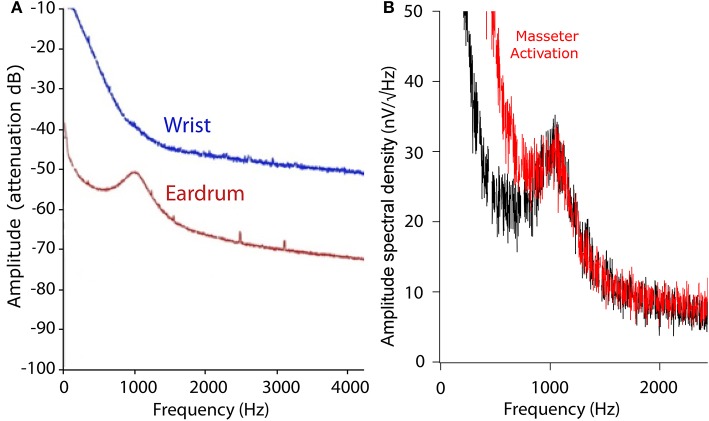
Tympanic electric noise ECG-like and EMG controls. (A) Comparison between TEN and ECG-like spectrums. The blue line shows the averaged spectrogram of a 360 s recording from an ECG-like signal with wrist electrodes, while the red line shows the spectrum of the TEN signal in the same volunteer. To compare the wrist and eardrum noise signal, the y-axis is shown in arbitrary units measured in dB of attenuation. The frequency components of the ECG-like signal are probably observed in the low frequency band (<100 Hz) of the corresponding power spectrum. (B) TEN spectrum with (red) and without (black) masseter muscle activation. Volunteers activated their masseter muscles through isometric contraction, with mouth closed during 1 min. Note that the muscle activation produces a power increase in the frequency band <800 Hz, but not in the 1,000 Hz peak, probably related to EMG activity.